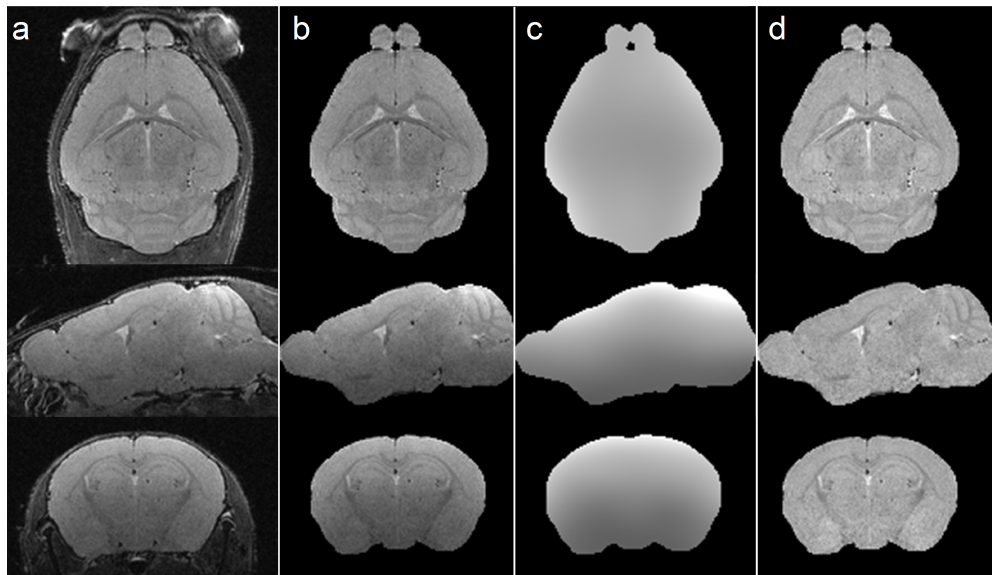
Fig 2. Example 9 week WT mouse images illustrating processing steps for volumetry analysis. Orthogonal views of the exampleT2-weighted in vivo dataset are shown in panel a . The images after semi-automated segmentation to remove signalfrom non-brainmaterial are shown in panel b . The bias field estimate due to surface coil sensitivity inhomogeneity obtainedfrom N4ITK software is shown in panel c . Panel d is the processed3D dataset ready for image registrationand